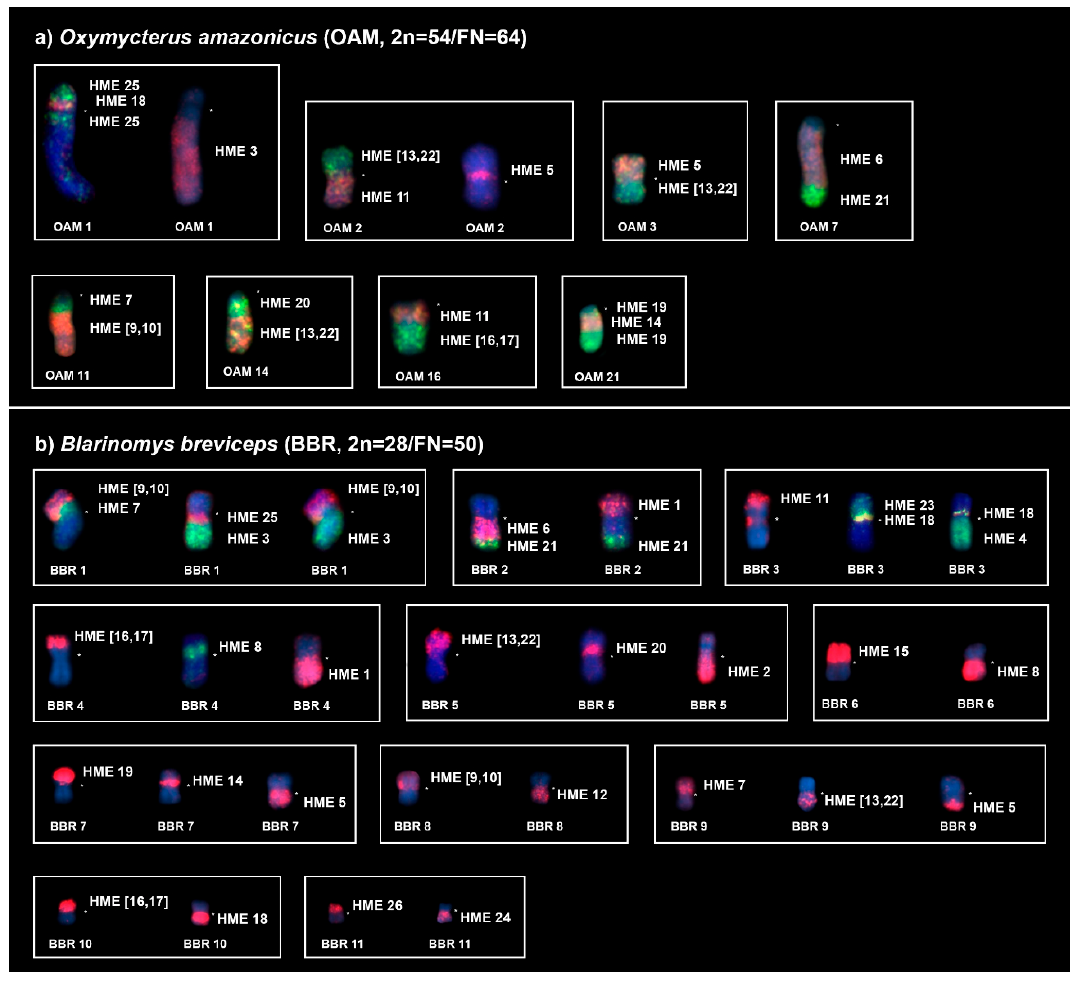
Figure 3. Chromosomal associations obtained from ( a ) Oxymycterus amazonicus (OAM) and ( b ) Blarinomys breviceps (BBR) using HME probes [23]. Each box corresponds to a chromosome pair that is shown in Figure 2 and exhibits chromosomal associations; for some chromosome pairs, single or multiple chromosomes are shown with different probes to exhibit that the HME whole-chromosome probes covered the entire chromosome. An asterisk indicates a centromere. HME whole-chromosome probes are shown as red (CY3), green (FITC), and yellow (CY3 + FITC); the counterstaining is blue (DAPI). Table 3. FISH signals detected for Oxymycterus amazonicus (OAM; 2n = 54, FN = 64) and Blarinomys breviceps (BBR; 2n = 28, FN = 50), as assessed based on hybridization with Hylaeamys megacephalus (HME) whole-chromosome probes [23].